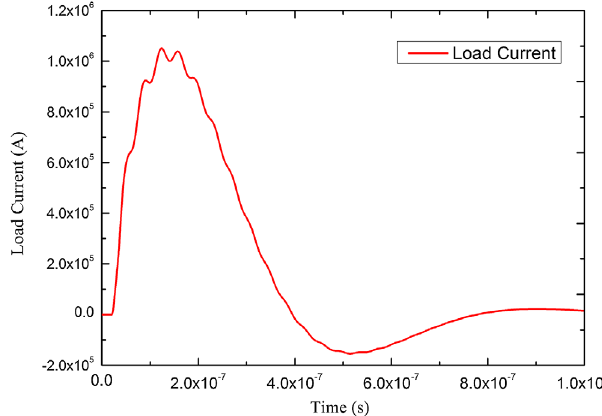
FIG. 6. Load current simulation result of a hybrid mode